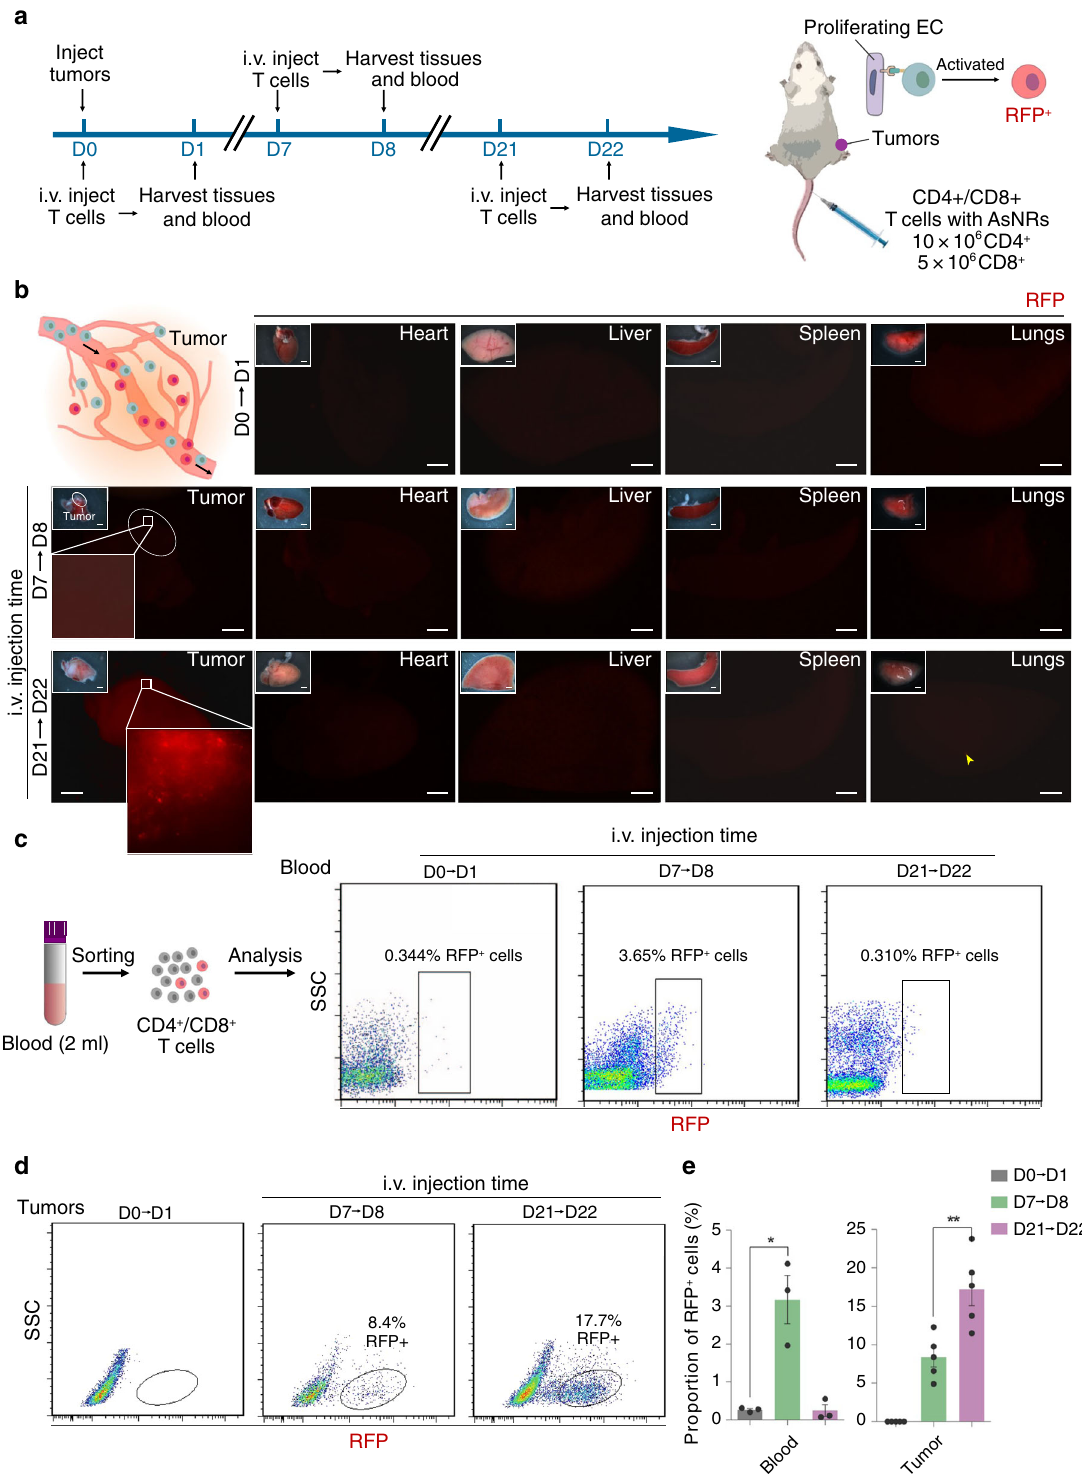
Fig. 5 Engineered cells with AsNRs can sense the sprouting vessels of tumors in adults. a Schematic showing the experimental strategy. Tissue and blood were collected at 24 h after engineered cell injection and engineered cells turned red after they sensed sprouting vessels. b Whole-mount fl uorescence images of tissues showing that engineered T cells failed to turn red in the hearts, livers, spleens, or lungs, but robust RFP signals were detected in tumors, indicating that the AsNRs were speci fi c for Apj in vivo. c CD4 + and CD8 + T cells from blood were sorted and the proportion of RFP- positive cells increased signi fi cantly at D7 compared with those at D0 and D21. d The proportion of RFP + cells increased at D21, indicating that engineered cells were retargeted to tumors as tumors grew. e Proportion of RFP + cells in blood and tumors at D0, D7, and D21. (blood: n = 3 samples; tumor: n = 5 mice per group). Scale bars = 1 mm in b . Error bars: SEM. Signi fi cance: * p <